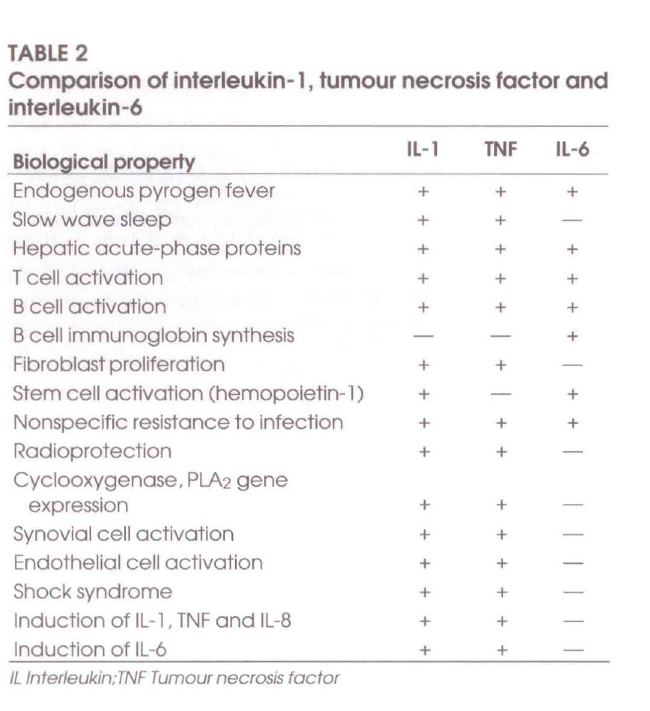
Comparison of interleukin- 1, tumour necrosis factor and